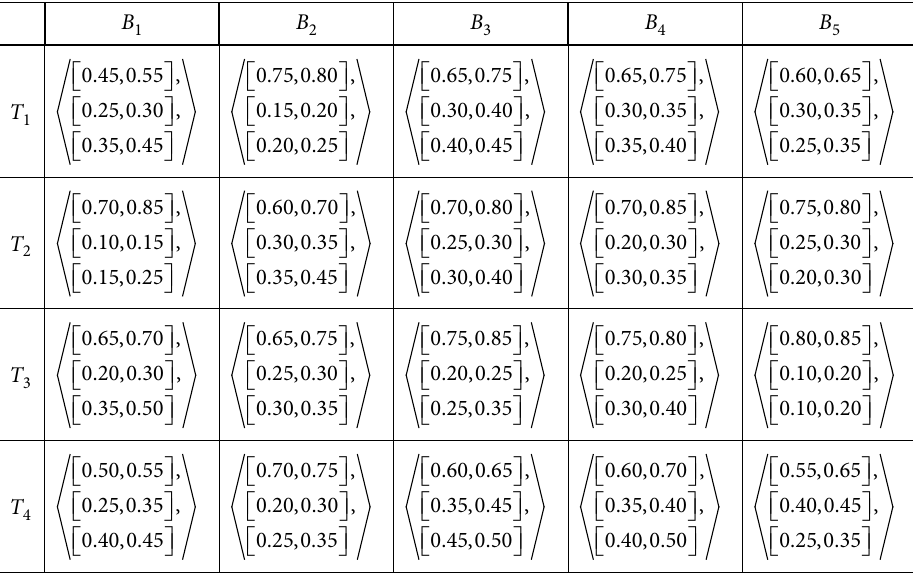
Table 6. Standardized decision matrix